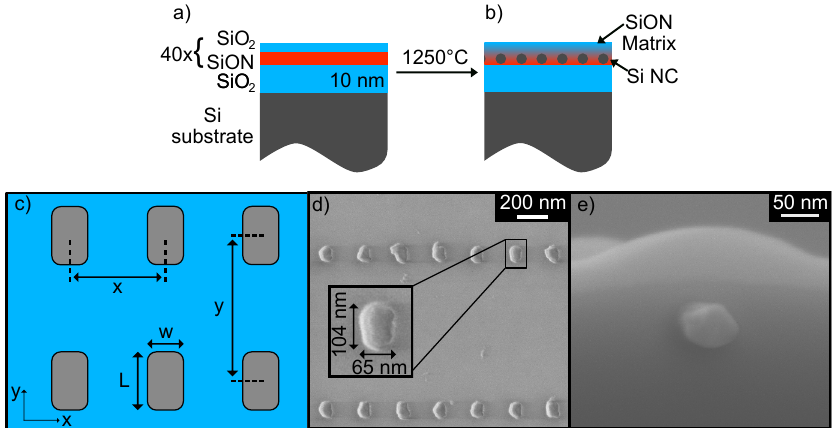
Figure 1. ( a ) Schematic sketch of the sample structure including the SiON/SiO 2 superlattice. ( b ) Si NCs embedded in a SiON matrix after high-temperature treatment. ( c ) Schematic top view of the antennas on the layered system with the used terms of the parameters. ( d ) Nanoantennas before overgrowth with a length of 100nm, a width of 80nm, and a lattice constant of 250nm (preset sizes of the lithography mask). The inset shows an antenna with the actual measured size